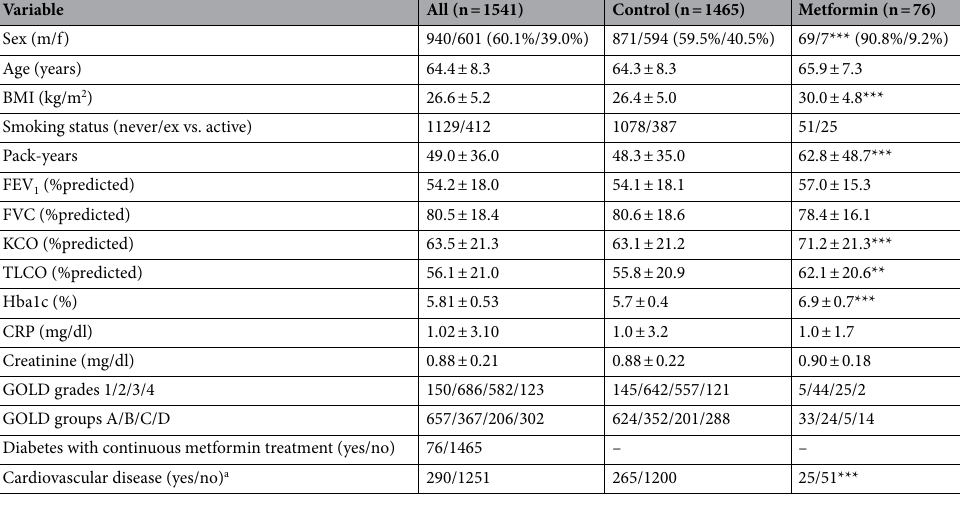
Table 1. Baseline characteristics. The table shows the baseline characteristics of the study cohort. For continuous variables, mean values and standard deviations are given. Furthermore, categorical data for sex, smoking status, GOLD grades and groups, diagnosis of diabetes, diagnosis of cardiovascular disease and diabetes with continuous metformin treatment are given. For abbreviations see “Methods” section. a The diagnosis of cardiovascular disease comprised heart failure, coronary artery disease and myocardial infarction. This combination was chosen as the case numbers of the single items were low. ** p < 0.01, *** p <